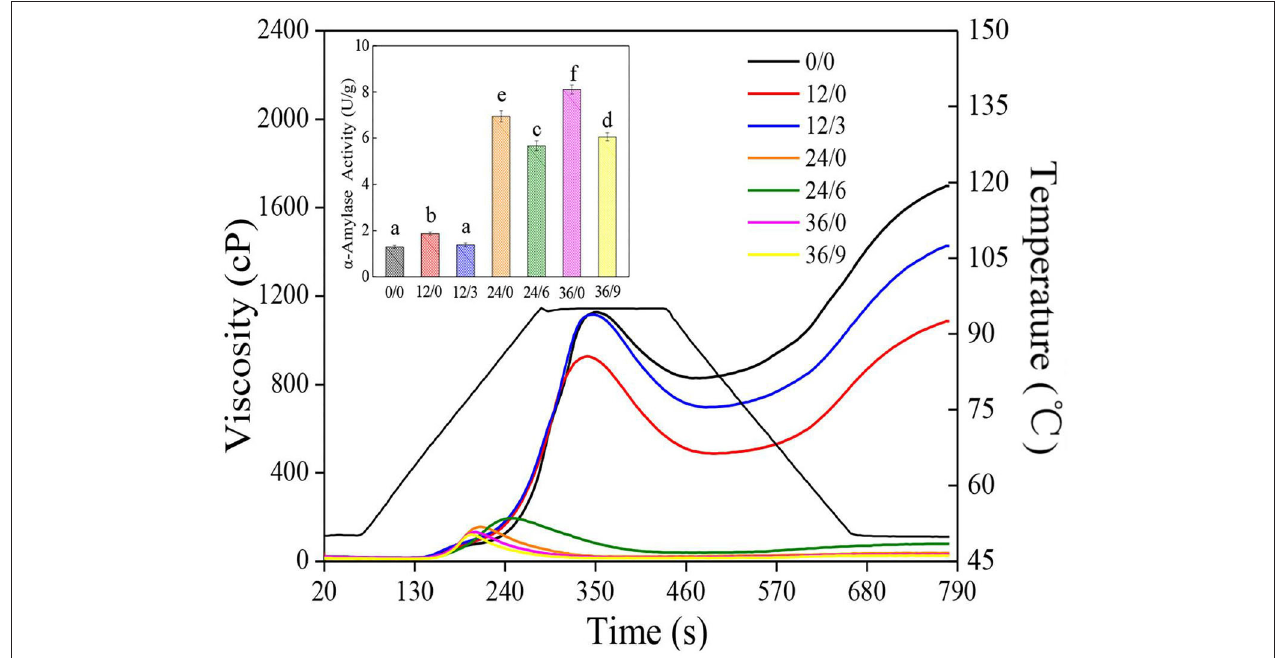
FIGURE 8 | The pasting properties of whole wheat flours during germination under UV-B radiation. The inset shows α -amylase activity of wheat. Different letters indicate the results of Duncan’s multiple range test at 5% level of significant difference among different germination and UV-B radiation time, respectively.